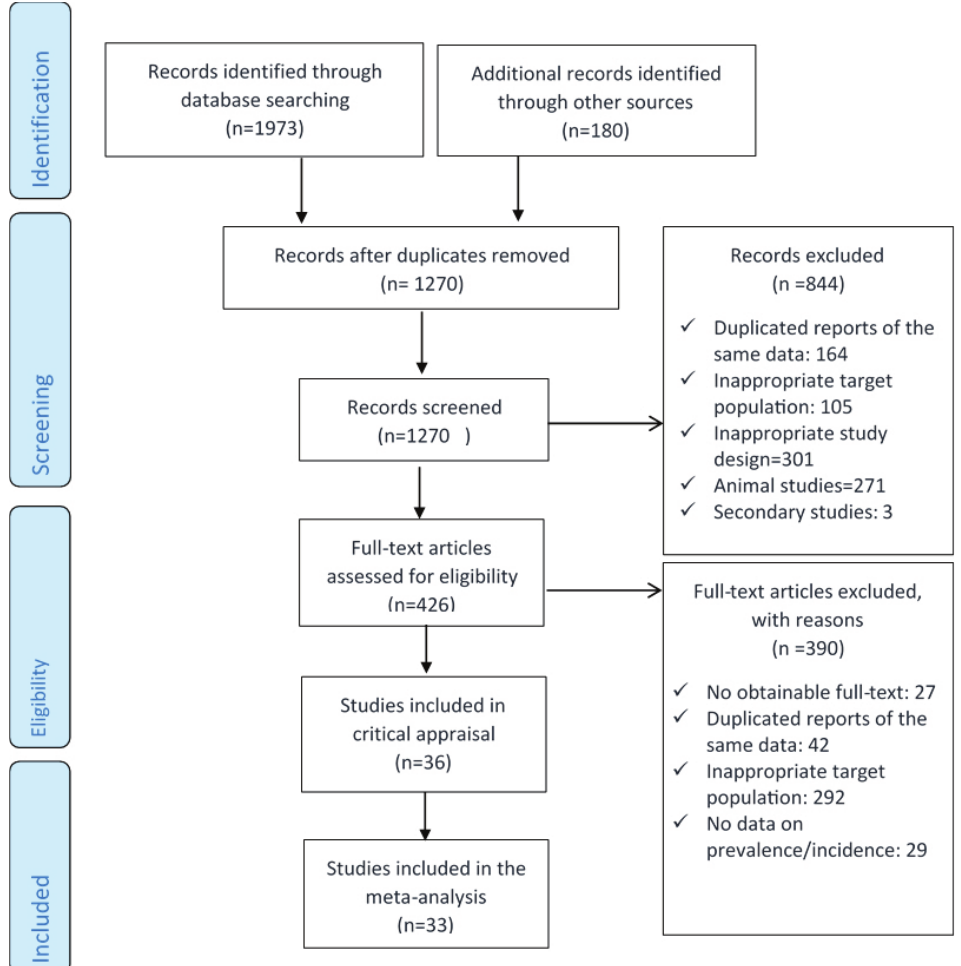
Figure 1. Flow diagram summarizing the systematic search and review process for identifying evidence regarding the prevalence and diabetic retinopathy. Inclusion and exclusion criteria are provided in the